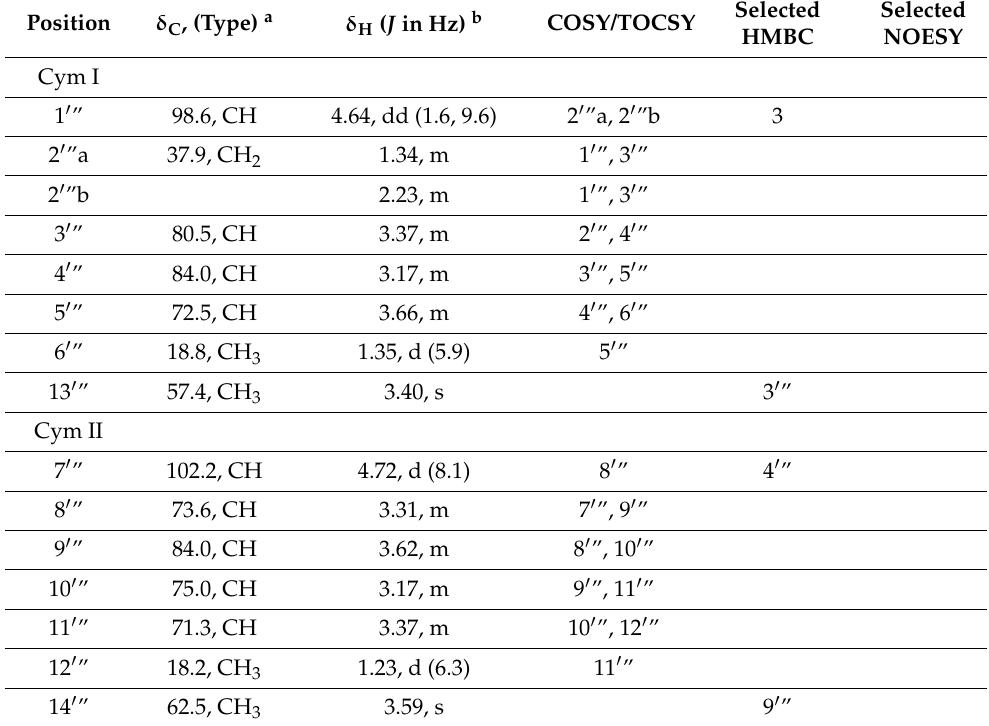
a Measured at 100 MHz. b Measured at 400 MHz. These are the abbreviation of NMR peak multipliaca- tion and explained as d = doublet, dd = doublet of doublet, m = multiplet, s = singlet, brq = broad quarted, brs = broad singlet.